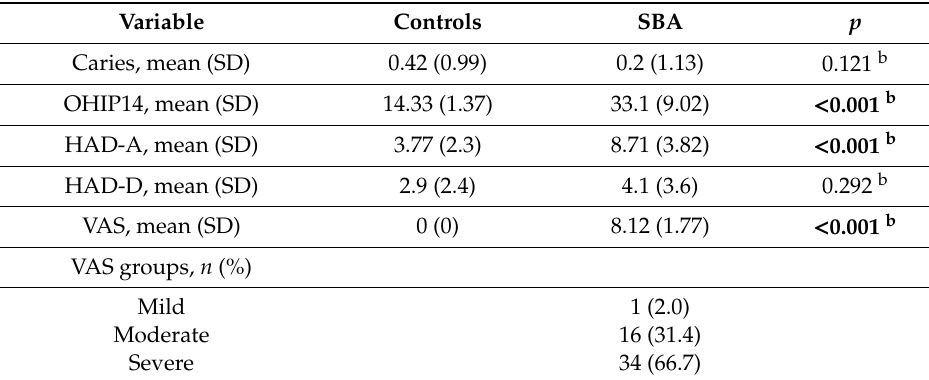
Figure 2. Salivary alpha-amylase (sAA; ( a )), immunoglobulin A (IgA; ( b )) and macrophage inflammatory protein-4 (MIP4; ( c )) corrected by salivary flow in healthy controls ( n = 31) and patients with burning mouth syndrome (BMS; n = 51). Difference of medians and means ± SD for sAA are 44.0 and 47.4 ± 15.91, for IgA are 119.9 and 147.6 ± 38.4 and for MIP4 are 13.0 and 33.6 ± 27.2.